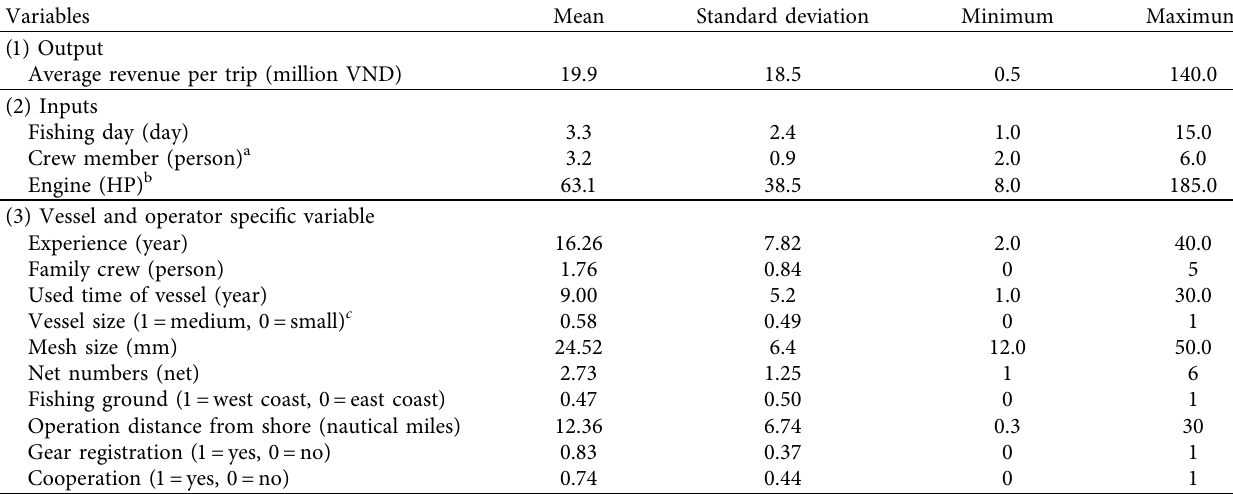
Table 1: Input and output variables used in the